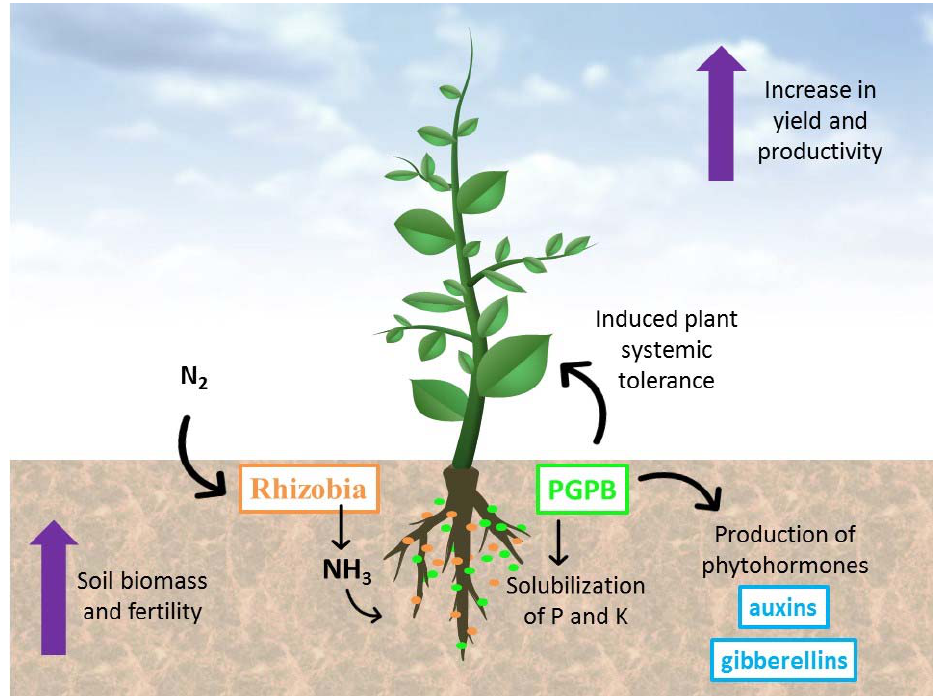
Figure 1. Main benefits of inoculation with rhizobia and plant-growth-promoting bacteria (PGPB). Biological nitrogen fixation (BNF), phosphate (P) and potassium (K) solubilization, phytohormone production (auxins and gibberellins), and induced plant systemic tolerance to abiotic and biotic stresses are represented. As benefits, there are increases in biomass production, yield, and improvement in soil fertility.